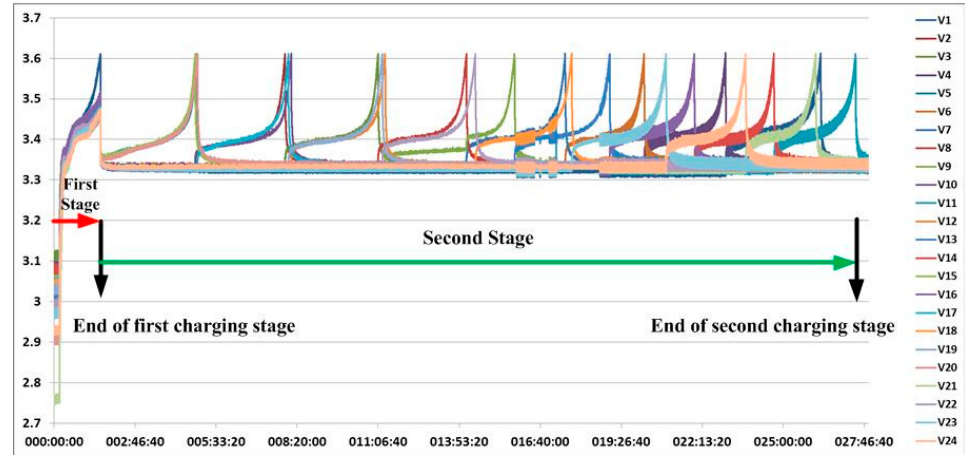
Figure 9. Results of the two-staged charging method.